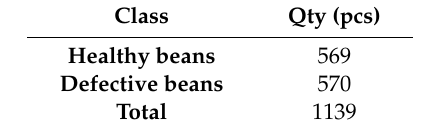
Figure 5. Spectral signature of the healthy and insect damaged coffee beans.